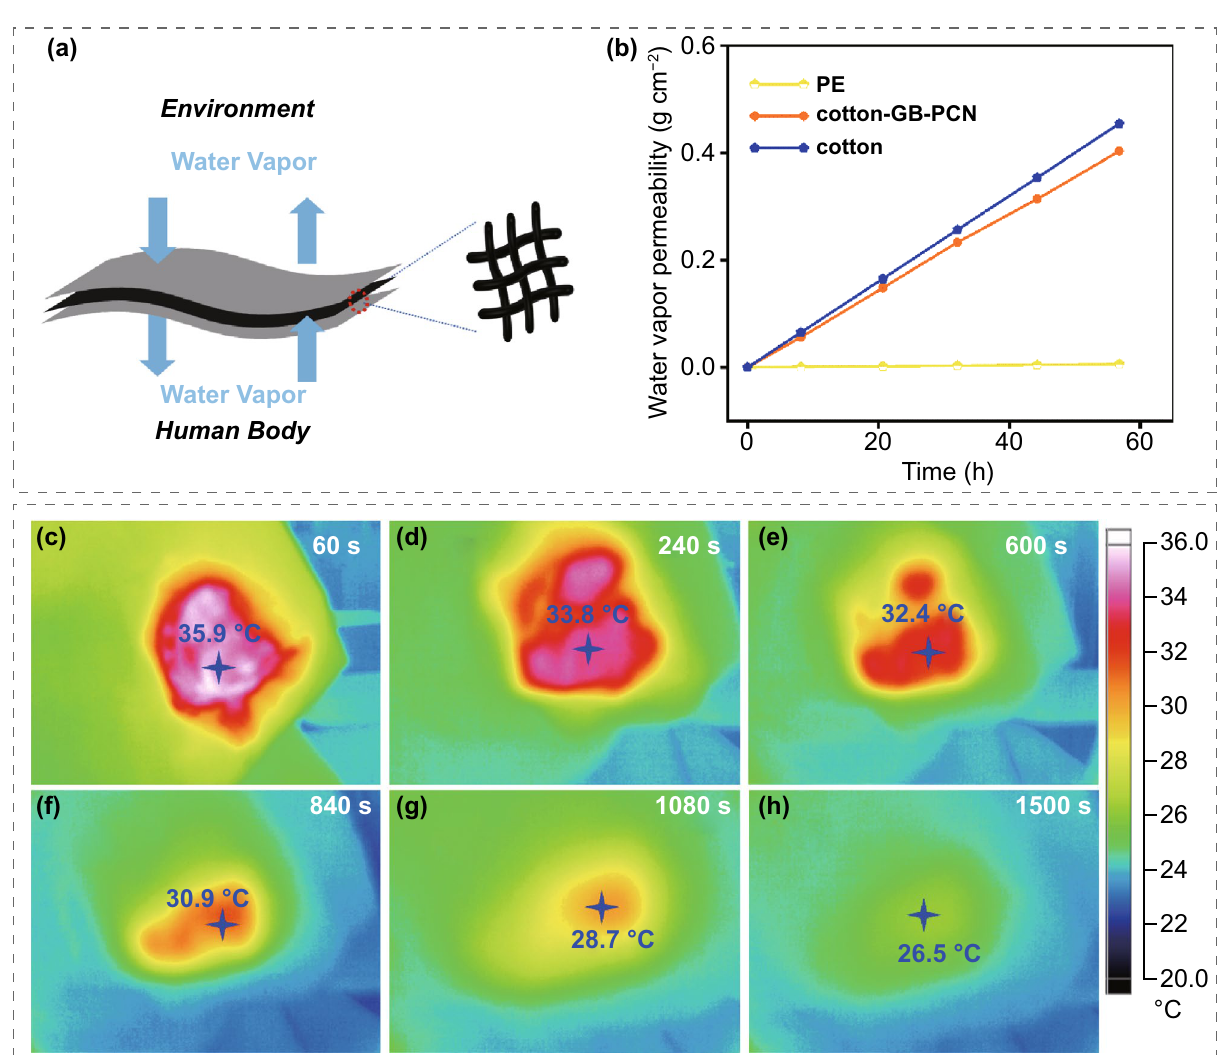
Fig. 4 Wearable thermal management in clothing. a Schematic of sandwich-type human thermal management devices. b Water vapor transmis- sion of polyethylene (PE), cotton and cotton-E-2 GB-PCN. IR images of E-2 GB-PCN used for clothing thermal management at different time of c 60 s, d 240 s, e 600 s, f 840 s, g 1080 s, and h 1500